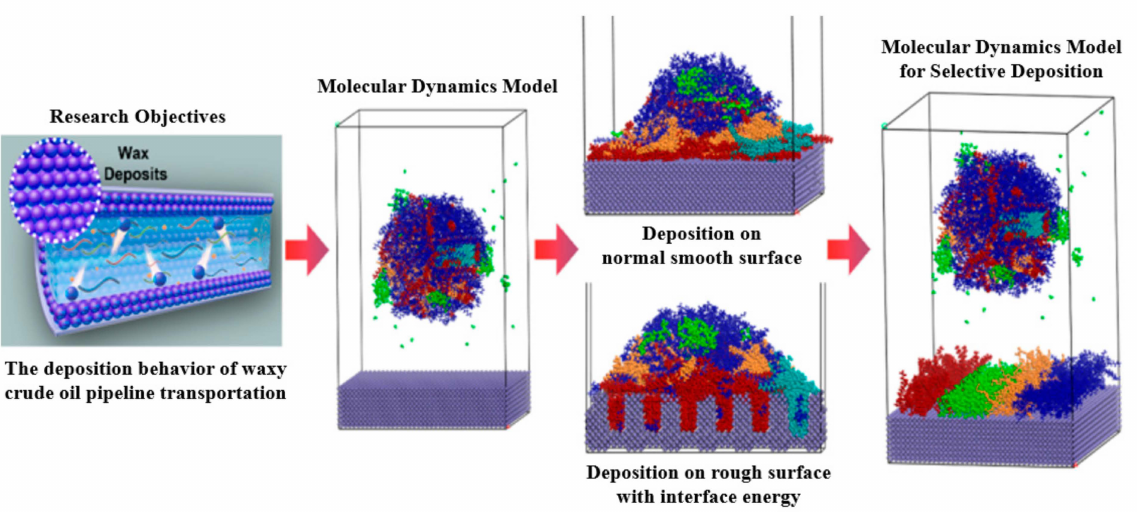
Figure 12. Schematic diagram of molecular dynamics characterization of wax molecules sticking on wall process